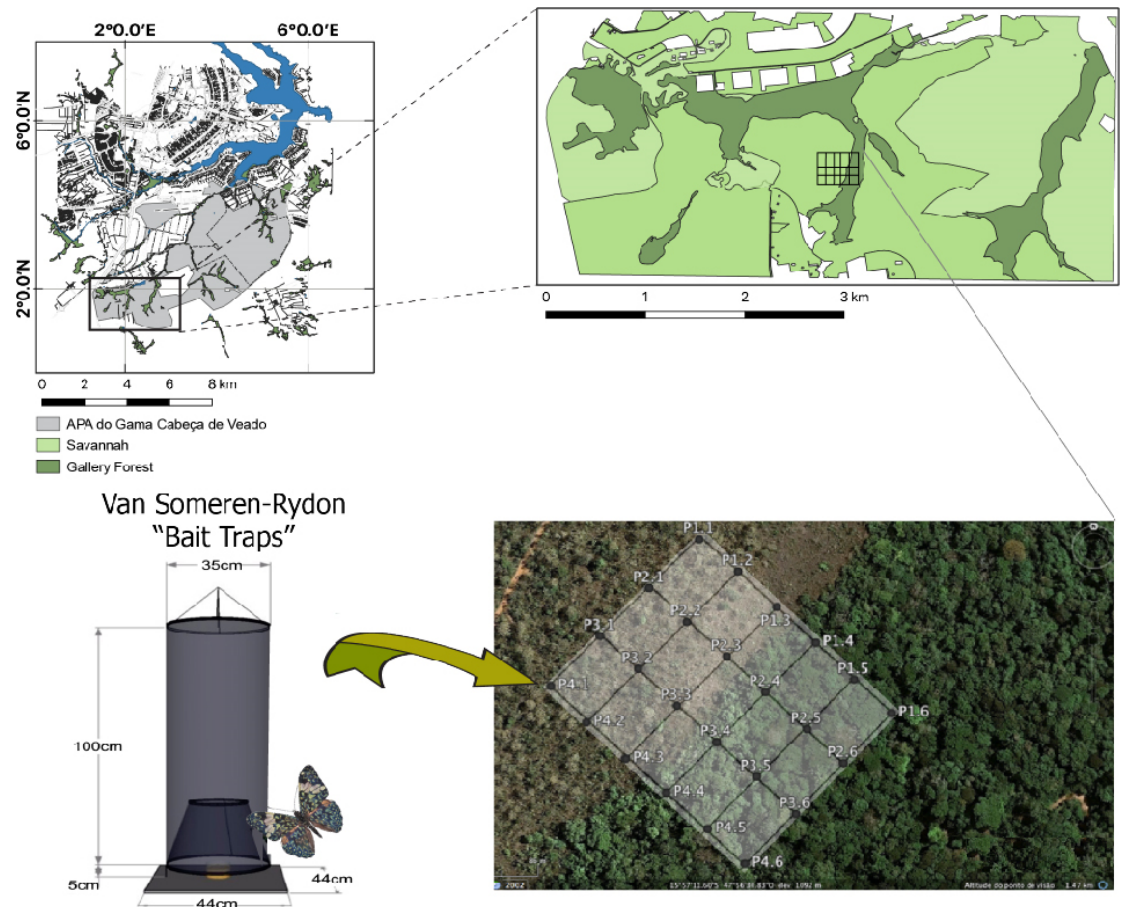
Figure 1. Experimental 1.8 ha (150 vs. 120 m) grid created at “Fazenda Á gua Limpa”, located at “APA do Gama Cabeça de Veado” a 10,000 ha conservation unity near Bras í lia, Distrito Federal, Central